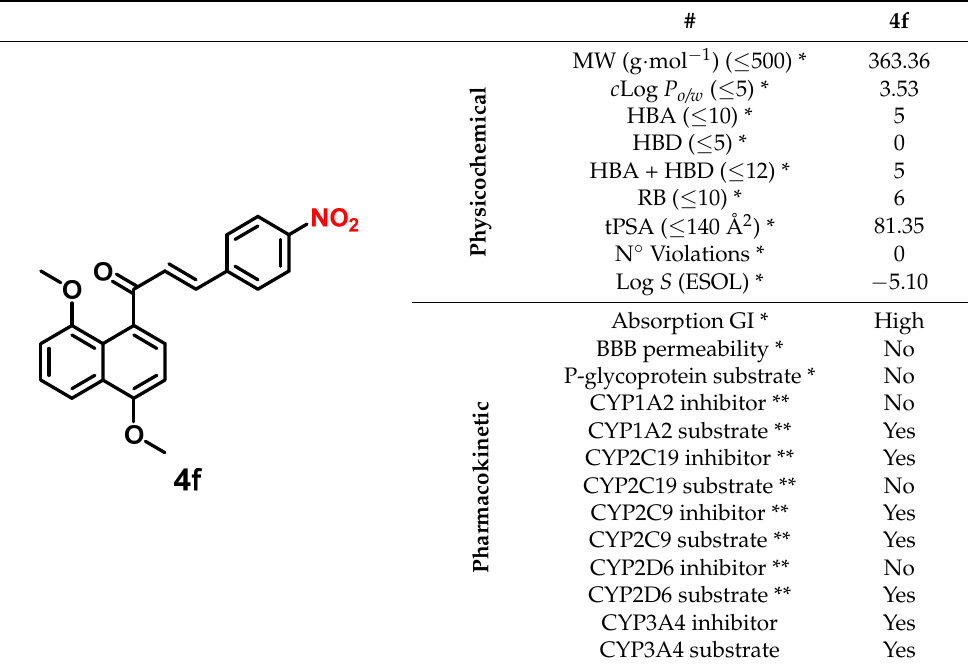
Table 2. In silico prediction of physicochemical (Lipinski’s 5 Rule and Veber's extension), pharmacokinetics, and toxicity properties of 4f